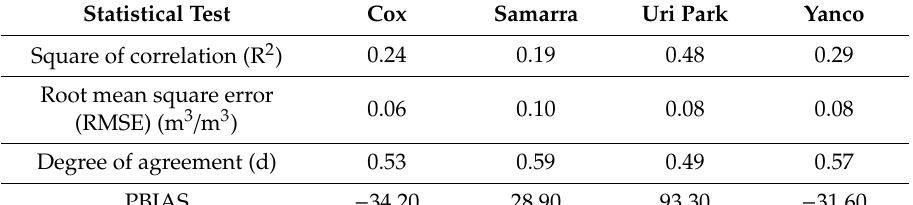
Table 6. Results of comparison between the in situ and SMAP data set at selected site of Australia . Statistical test